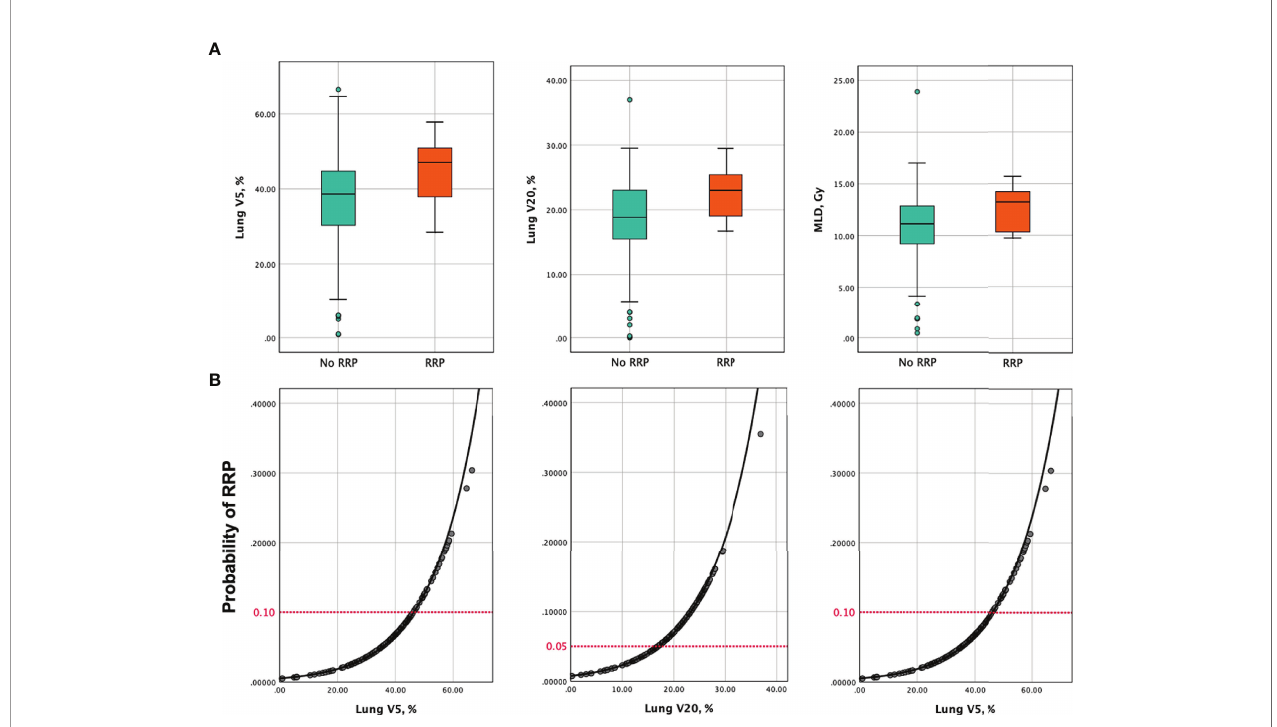
FIGURE 2 | (A) Box and whisker plots of V5, V20 and MLD among patients who developed RRP versus those without. (B) Probability of developing RRP as a function of V5, V20, and MLD. Predictors of RRP are represented in separate models. The red horizontal dashed lines indicate the probability of RRP corresponding to the recommended dose metrics constraints in this analysis (V5 ≤ 46.3%, V20 ≤ 16.7%, MLD ≤ 12.9 Gy). V5, percent volume of lung receiving ≥ 5 Gy; V20, percent volume of lung receiving ≥ 20 Gy; MLD, mean lung dose; RRP, radiation recall